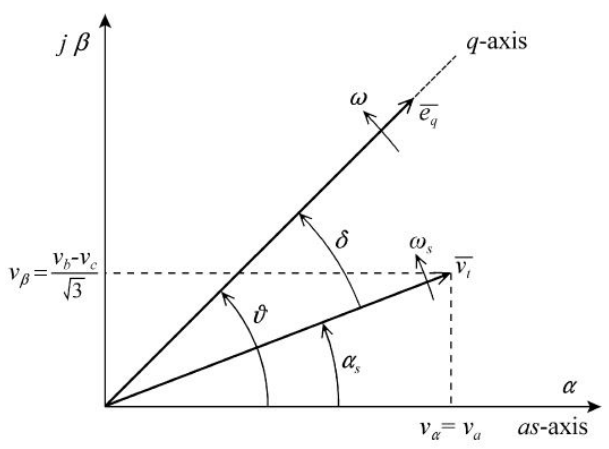
Figure 4. Vector diagram representing the definition of the load angle.